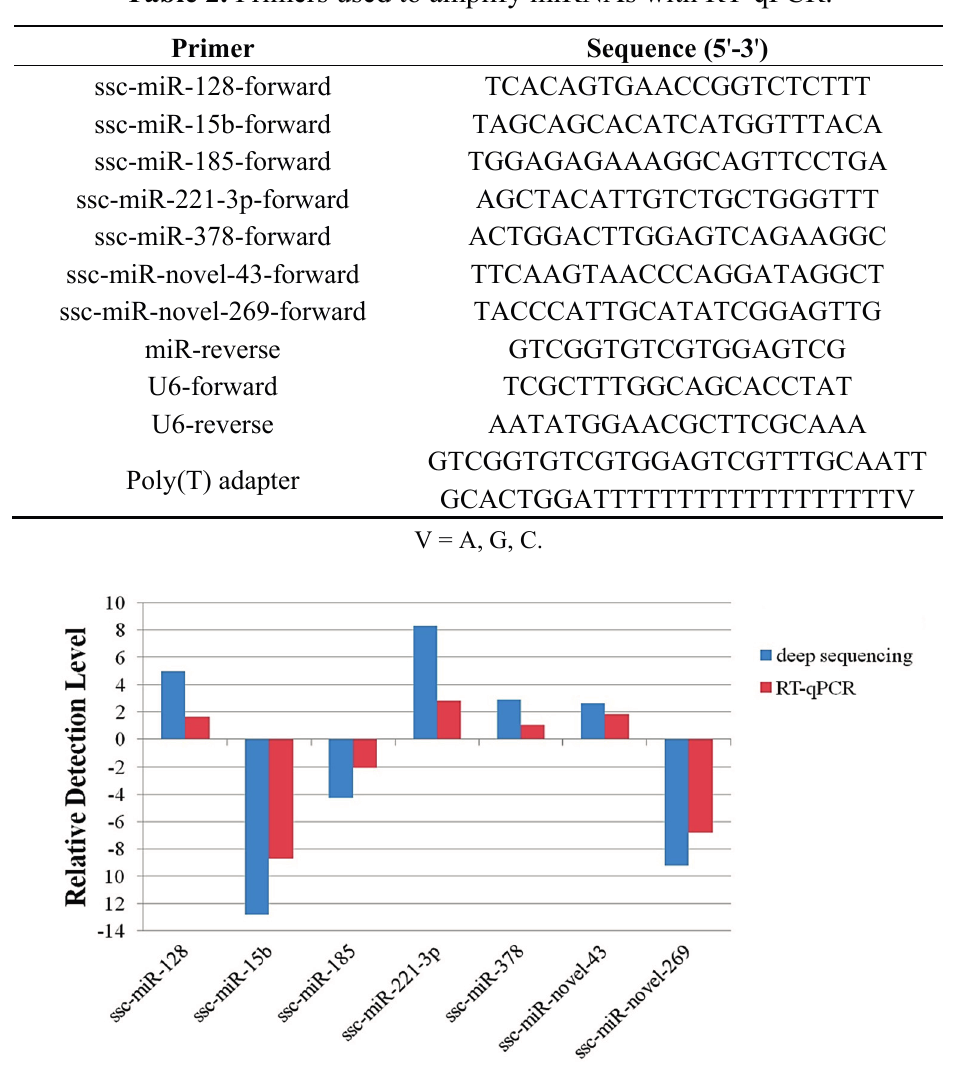
Table 2. Primers used to amplify miRNAs with RT-qPCR.